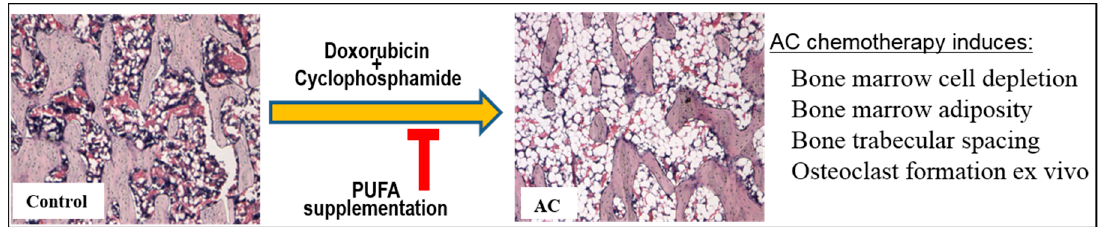
Figure 6. Long chain omega-3 polyunsaturated fatty acid (PUFA) supplementation helps to preserve bone and bone marrow microenvironment during adriamycin and cyclophosphamide (AC) combination chemotherapy. It protects against AC treatment-induced bone marrow cell depletion and adiposity and attenuates separation of bone trabeculae in rats and osteoclast formation ex vivo.